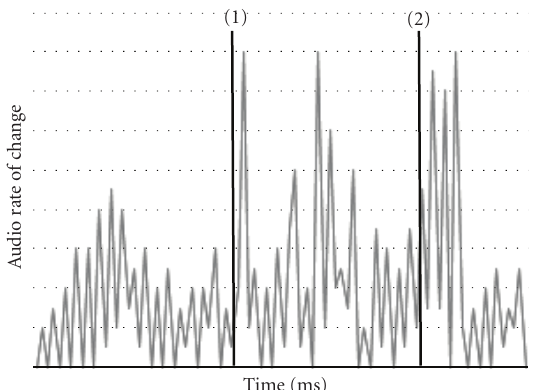
Figure 1: Audio rate of change versus time.